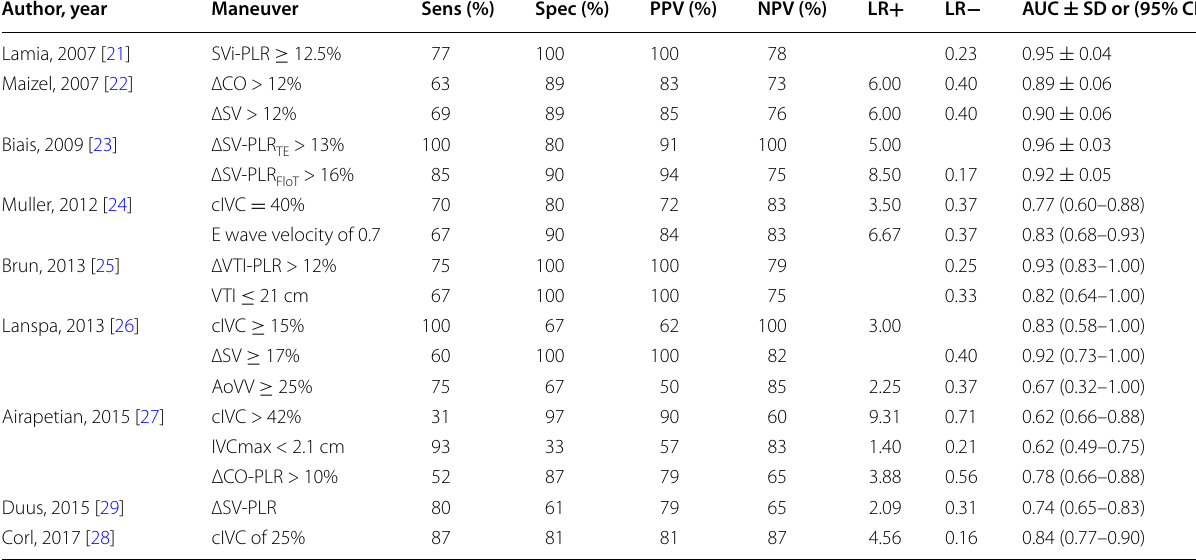
Table 4 Performance of included studies that addressed echocardiography maneuvers, pulse contour analysis or nonin- vasive cardiac output monitor (NICOM ® ) to predict fluid responsiveness in spontaneously breathing